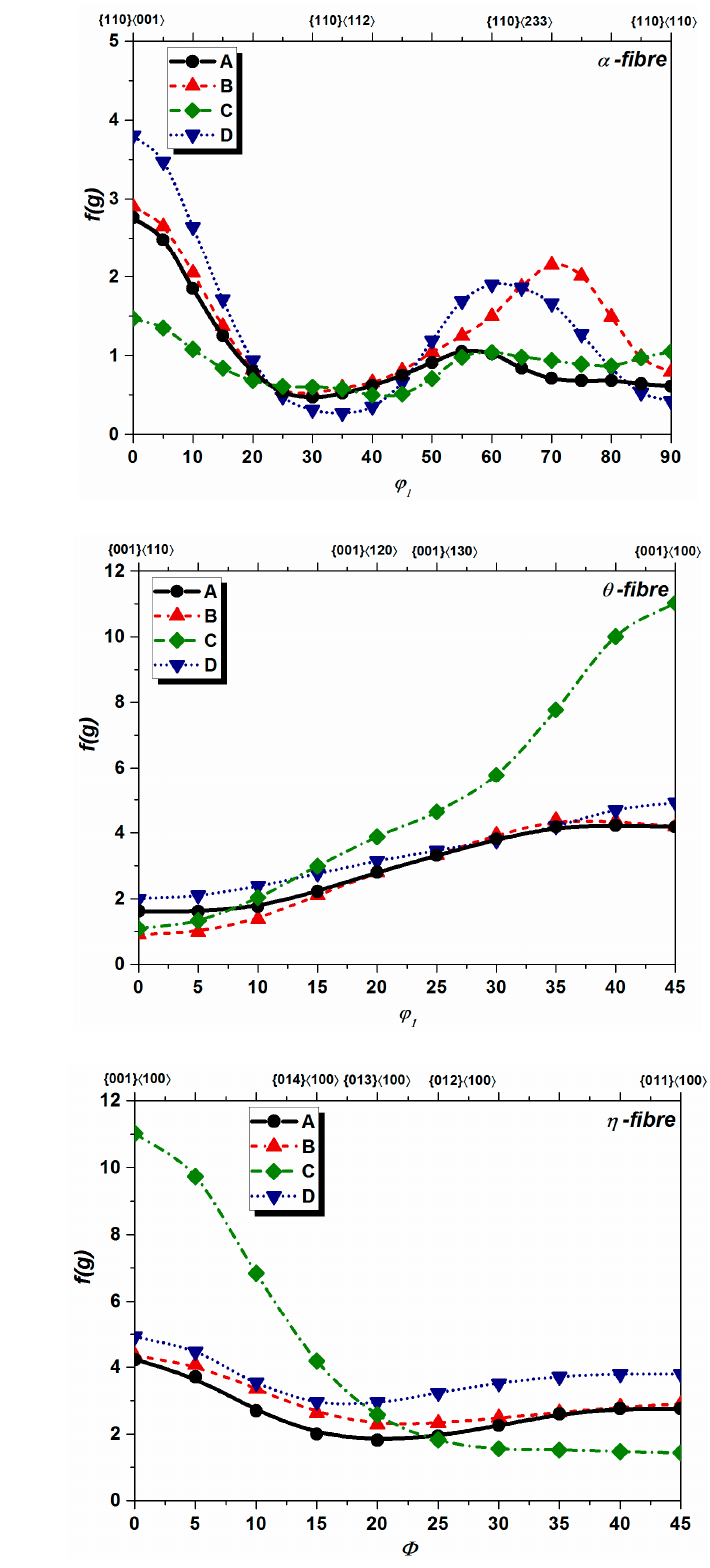
Figure 6. Distribution of orientations along the main texture fibres after annealing at 550 ◦ C: ( a ) α - fibre {011}//ND; ( b ) θ -fibre {001}//ND; ( c ) η -fibre